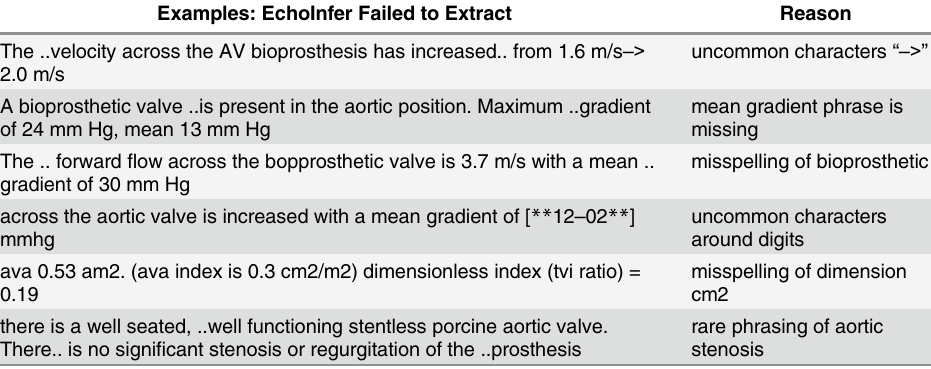
Table 6. Examples of non-standardized echocardiographic reporting that are not identified or extracted by EchoInfer. Examples: EchoInfer Failed to Extract